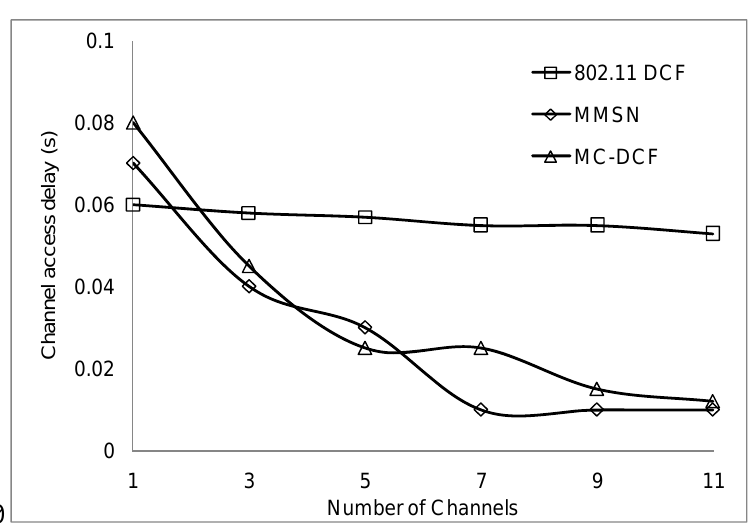
Figure 6. Delay impact on protocols.